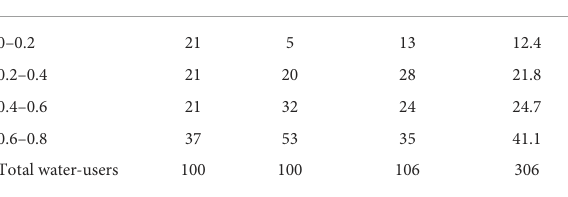
TABLE 2 Efficiency score distribution of water-users in SIS in KZN.